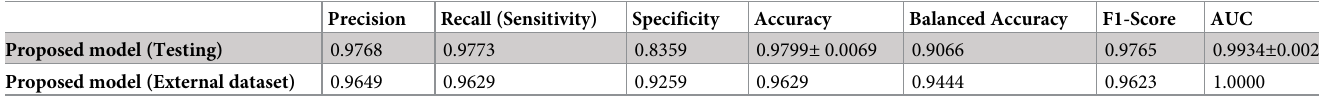
Table 3. Evaluation statistics of the proposed model with the candidate biomarker using the testing samples and the external dataset.